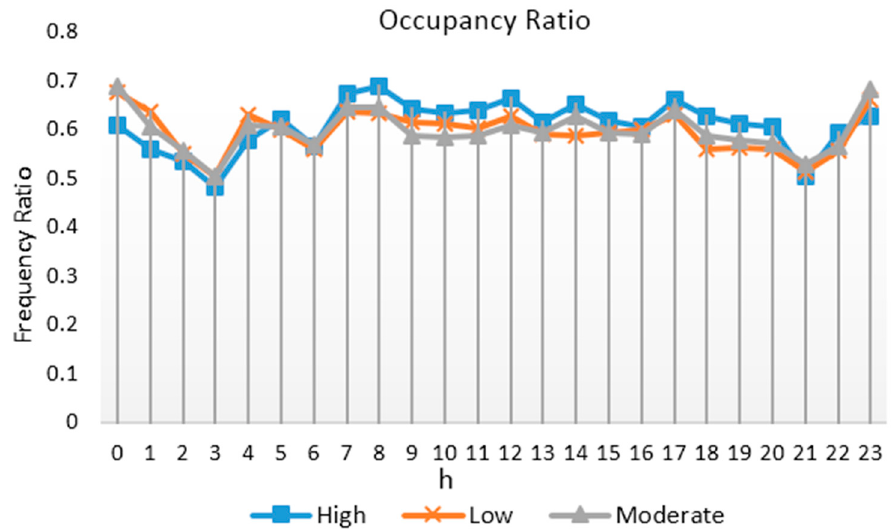
Figure 4. Occupancy ratio of high, moderate and low profitability drivers.